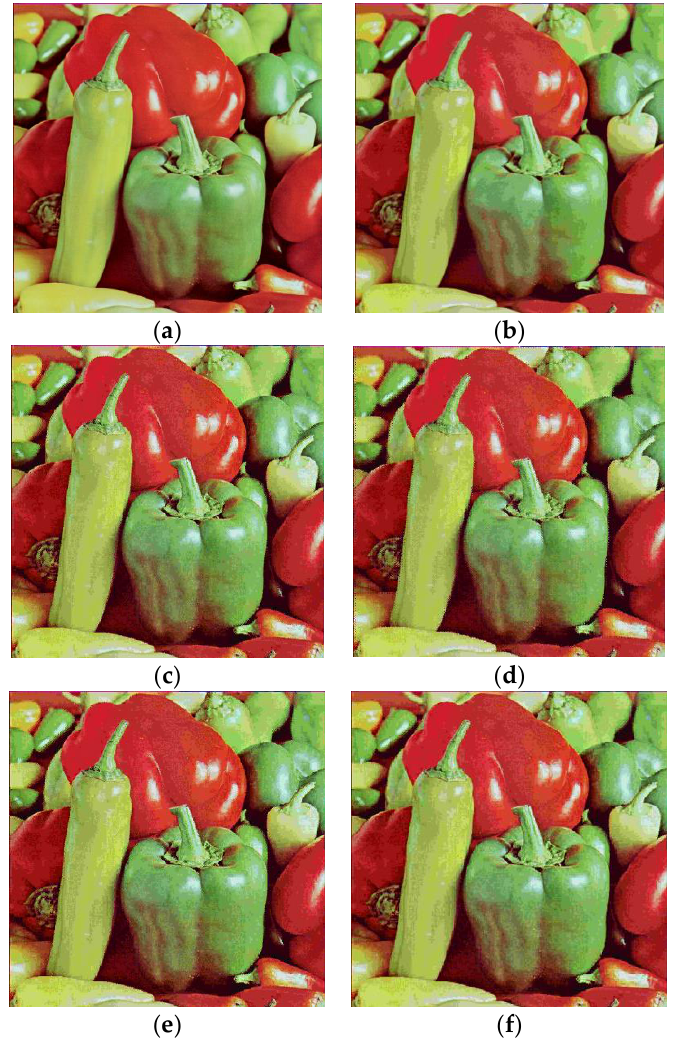
Figure 23. Result of JPEG false contour reduction on color image with quality factor Q = 5: ( a ) input image; ( b ) JPEG decoded image. The reconstructed images using: ( c ) ODBTC; ( d ) EDBTC; ( e ) DDBTC; and ( f ) DDBTC Gaussian methods.